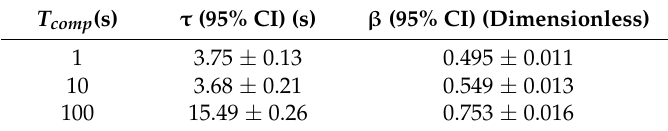
at plateau strain with hydrogels exposed to 9 mM glucose at pH 10, with different compression